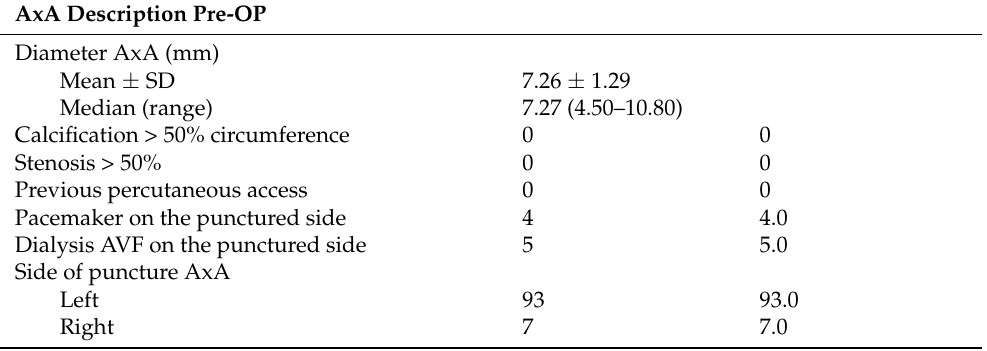
Table 2. Characteristics of the AxA.